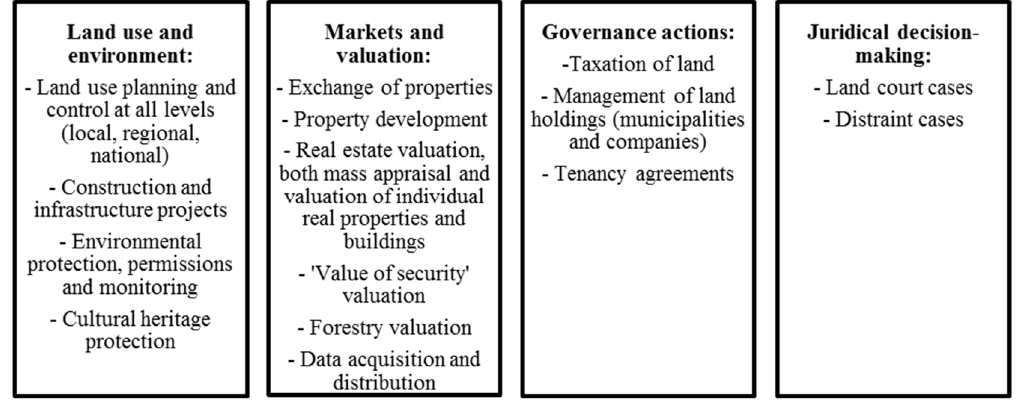
Figure 1. Four themes of FLIS use.